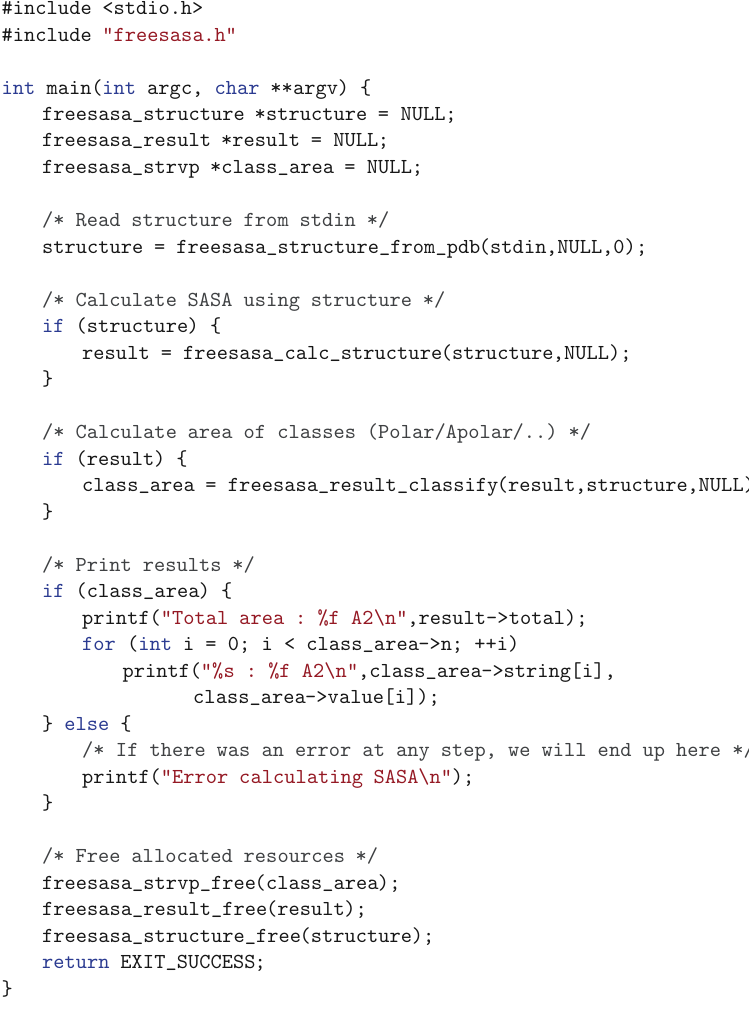
The API also allows the user to calculate the SASA of a set of coor- dinates with associated radii. The code below puts two atoms at � � positions 1 x = (1, 1, 1) and = (2, 2, 2) with radii r 2 x respectively, and outputs the SASA of the individual